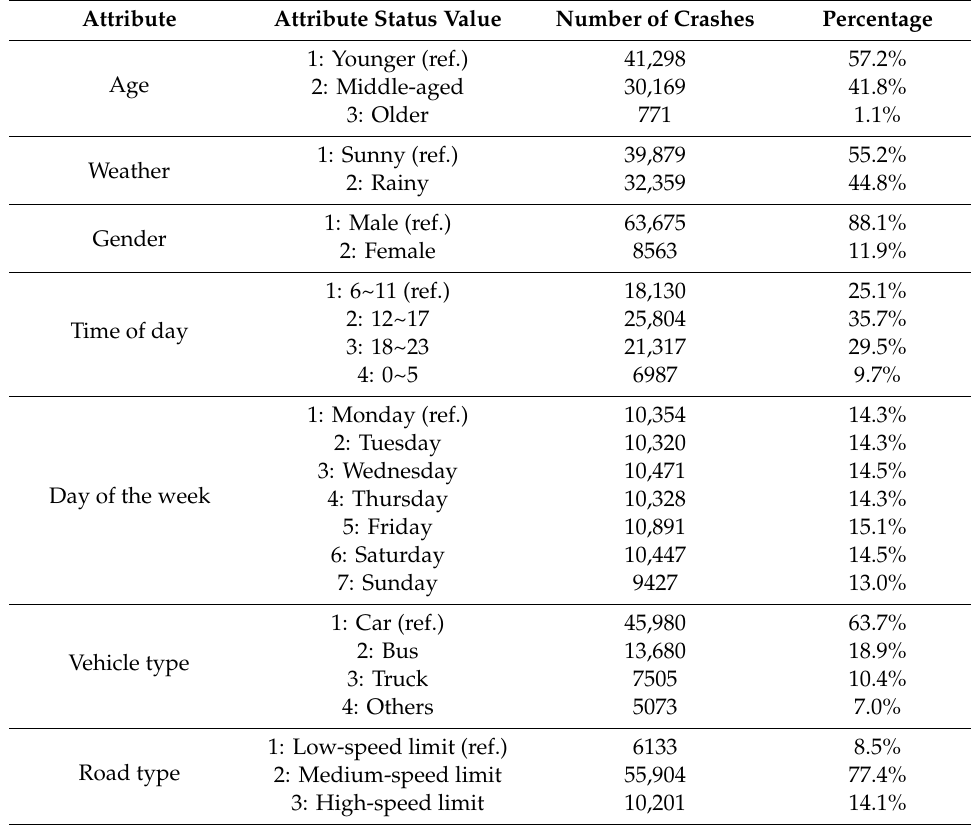
Table 1. Recorded crash